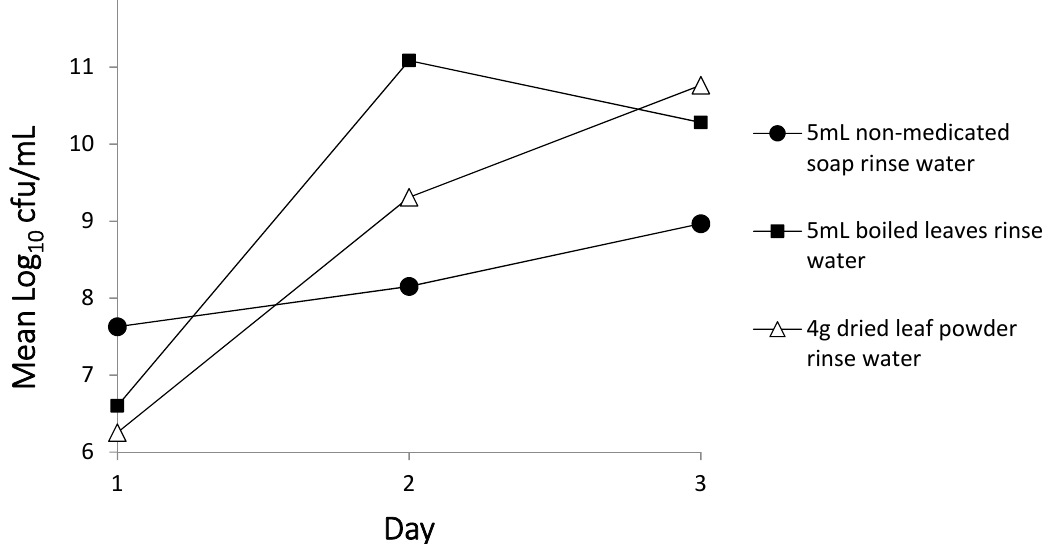
Figure 3. Mean log 10 cfu/mL reduction of E. coli of bottles containing different rinse water samples including the control (regular, non-medicated soap), boiled M. oleifera leaves, and dry M. oleifera leaf powder, Days 1–3.